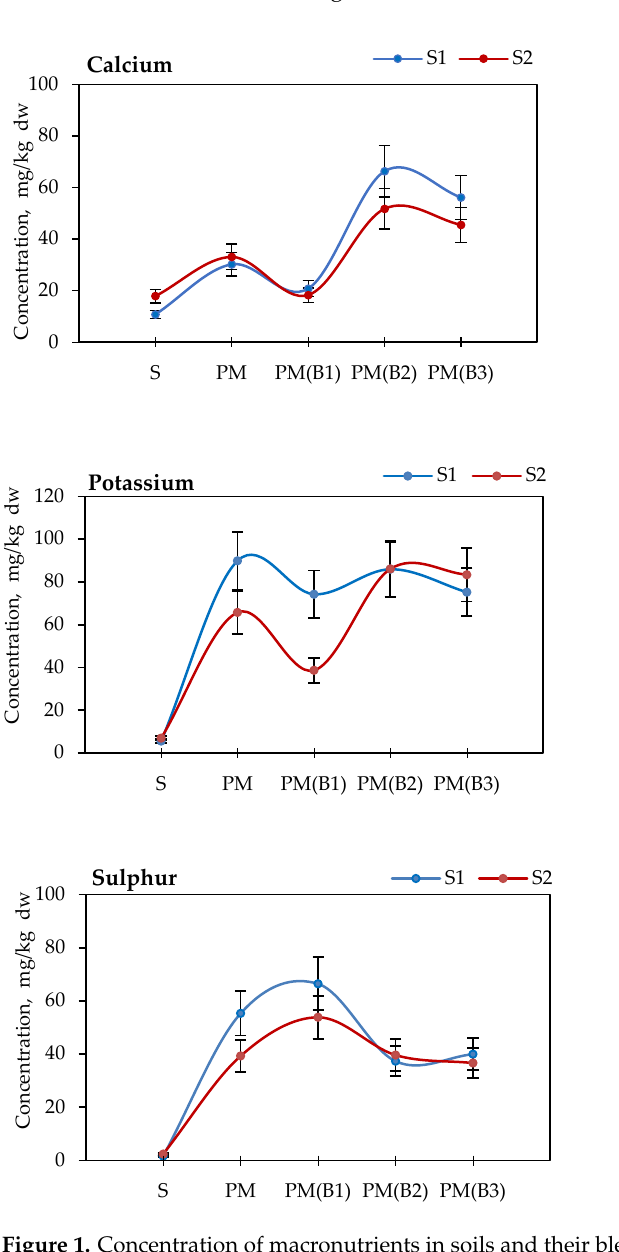
Figure 1. Concentration of macronutrients in soils and their blends treated with 2 wt.% poultry manure (PM) and biocidal agents: B1—calcium peroxide, B2—sodium percarbonate, B3—calcium hydroxide, S—soils without treatment (S1 or S2).